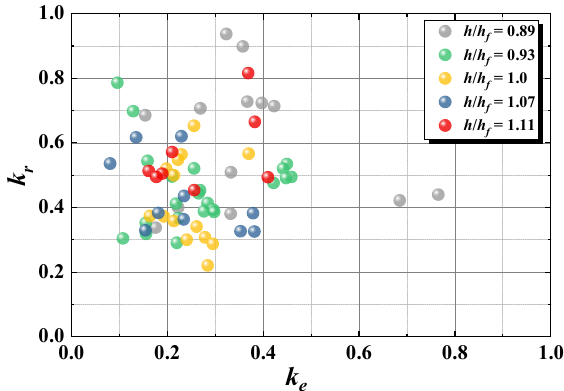
Figure 17. Relationship between k e and k r for pattern A.